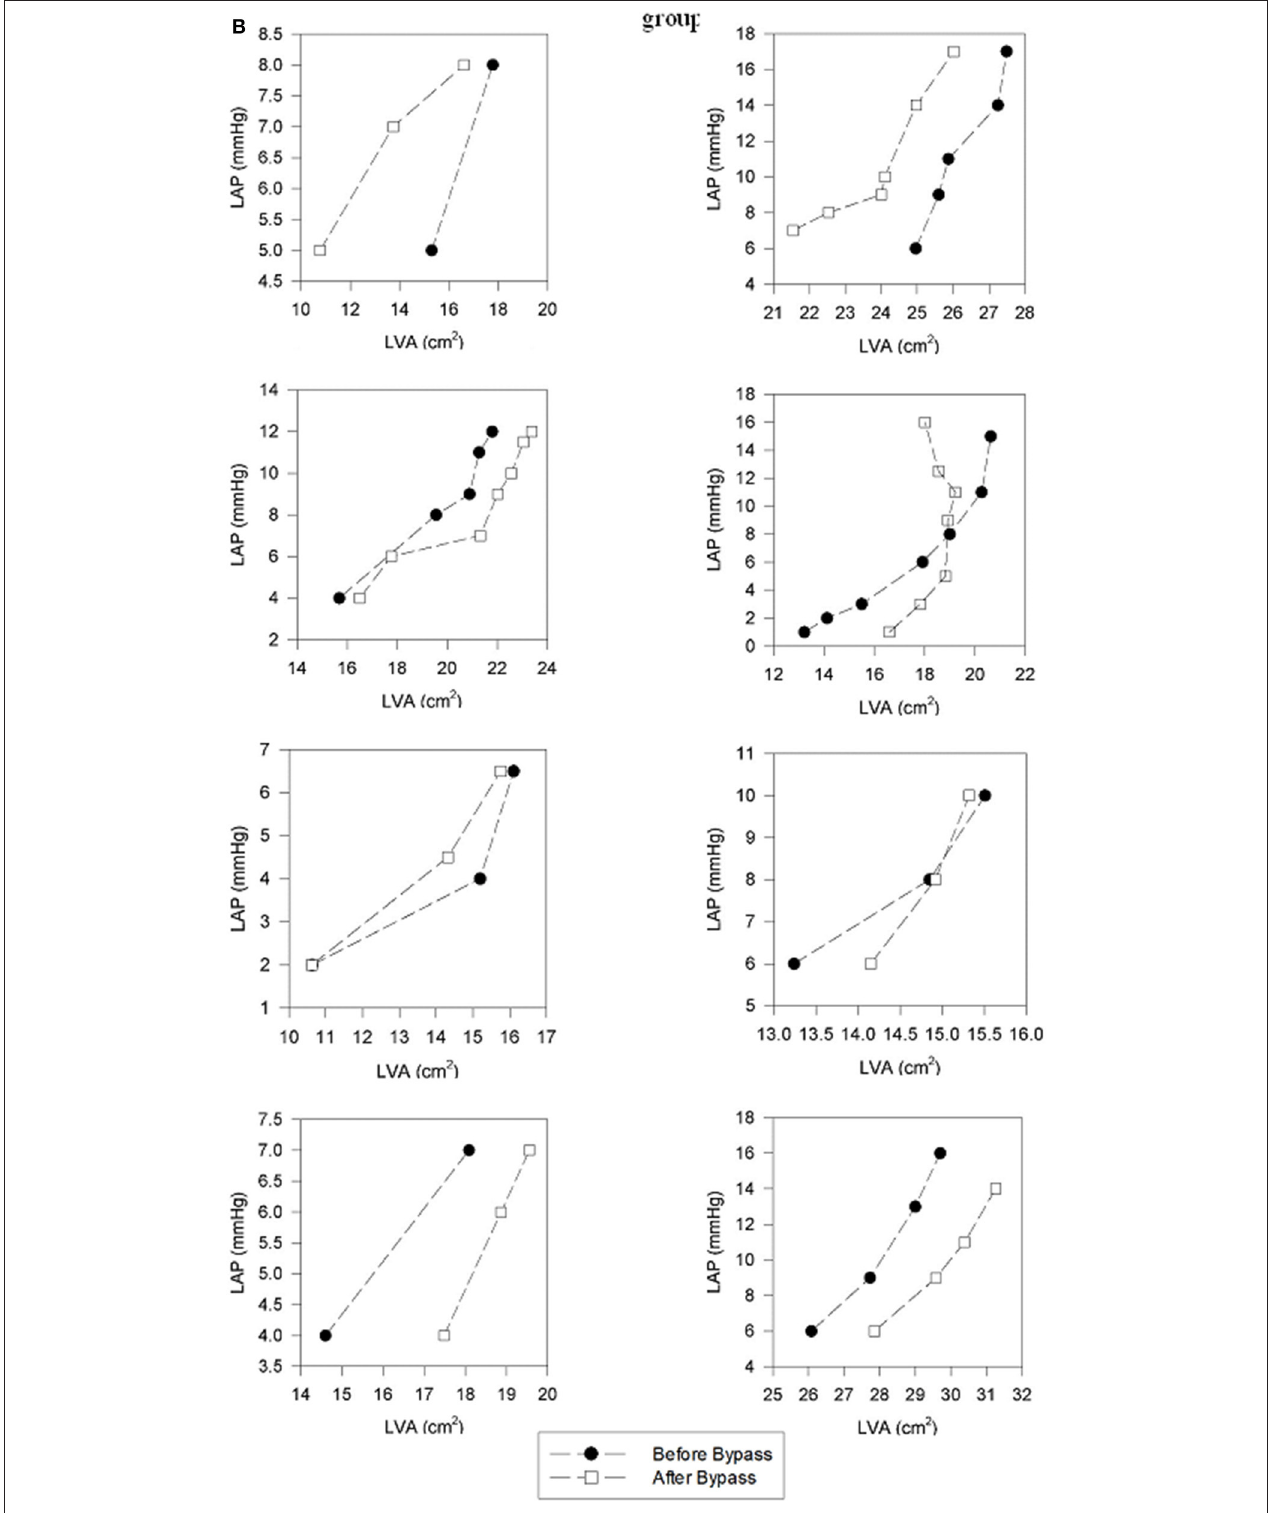
FIGURE A1 | Individual LV Left ventricular pressure-area relations pre- and post-bypass surgery. (A) Individual LV pressure-area relation pre- and post-bypass in the control patient; (B) Individual LV pressure-area relation pre- and post-bypass in acclimatized patients.